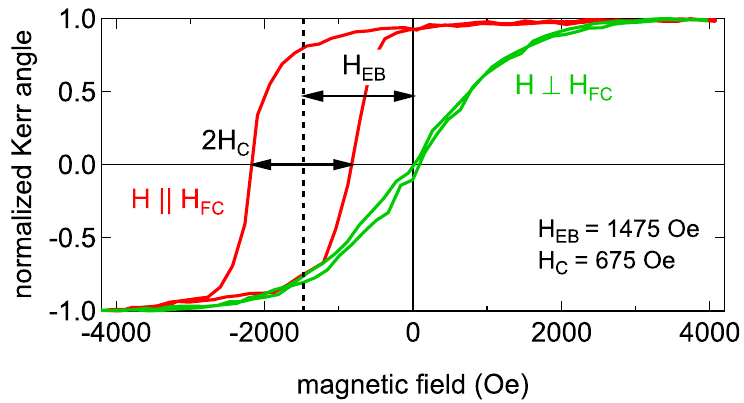
Figure 3. Typical hysteresis loop for a MnN/CoFe exchange bias system. (Reproduced with permis- sion from M. Meinert, Physical Review B; published by the American Physical Society, 2015) [14].